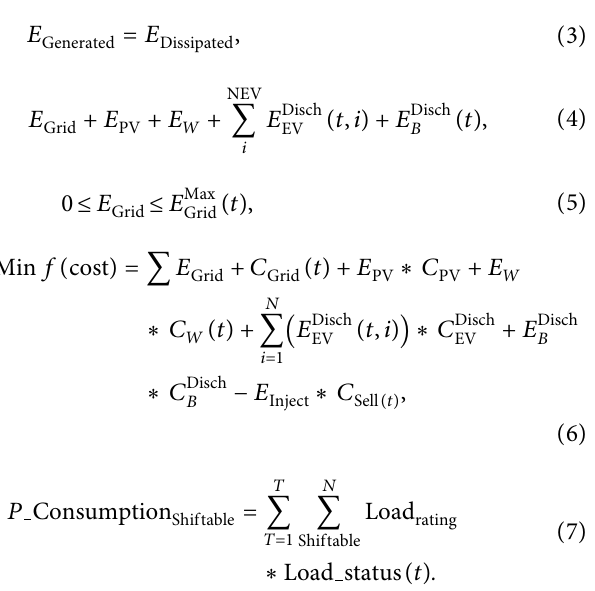
Table 2 represents constraints for the interconnected energy sources for the proposed framework as follows: max Where E is indicating the photovoltaic energy and pv E indicates the upper bound of solar. A -is average power and pv can vary between the defned parameters. P w indicates wind power, and u indicates the density of air. Energy generated by wind with respect to time is equal to the rotor area. Te smart grid constraint represents the power generated by other conventional energy sources. Te electric vehicle’s constraints open for future plugins to transfer the power for an electric vehicle. P CH indicates the charging of storage, and